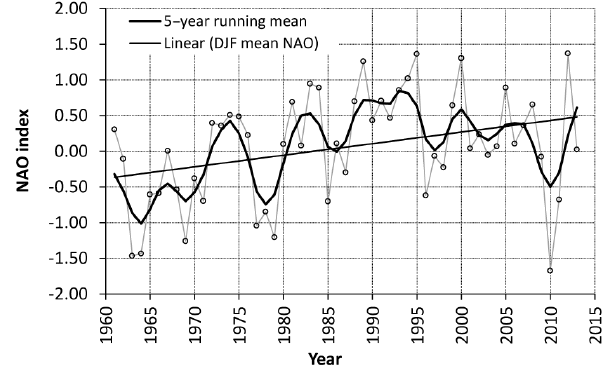
Figure 8. Winter NAO index from 1961 to 2013 (http://www.cpc. ncep.noaa.gov/products/precip/CWlink/pna/new.nao.shtml, last ac- cess: 11 February